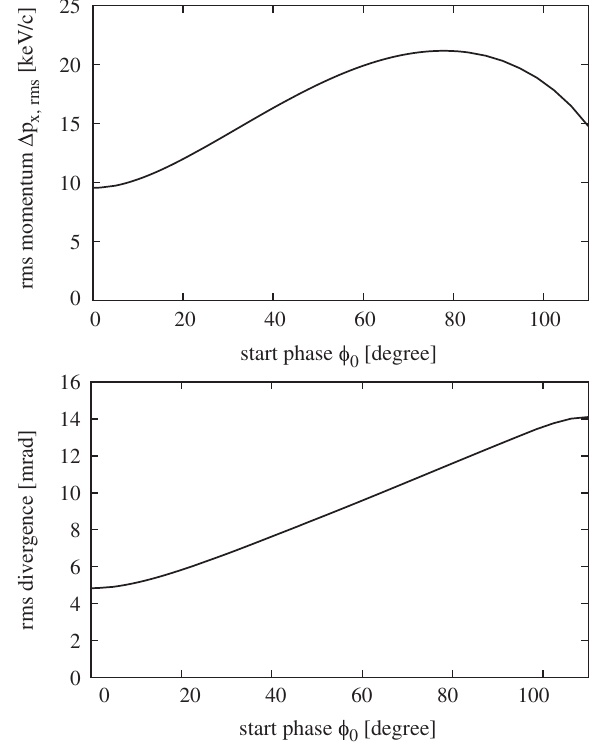
FIG. 13. Transverse rms momentum (top) and rms beam divergence (bottom) at the exit of a half-cell cavity operated at ¼ 0 . 0 mm, σ ¼ 0 . 75 mm. An 1.3 GHz, E 0 ¼ 50 MV = m, x x off initial constant current bunch of ϕ m ¼ 4 . 68 ° length has been used in the numerical